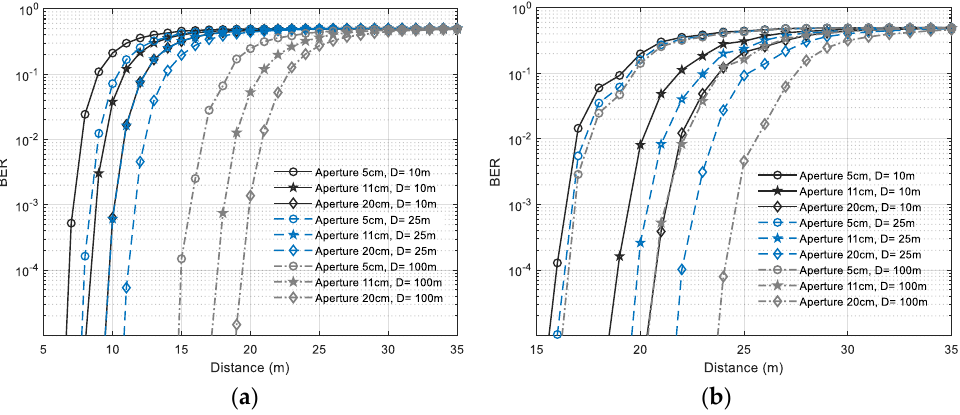
Figure 11. BER performance versus communication distance with different apertures and operation depths in coastal water for ( a ) FOV = 180°, ( b ) FOV = 15°.